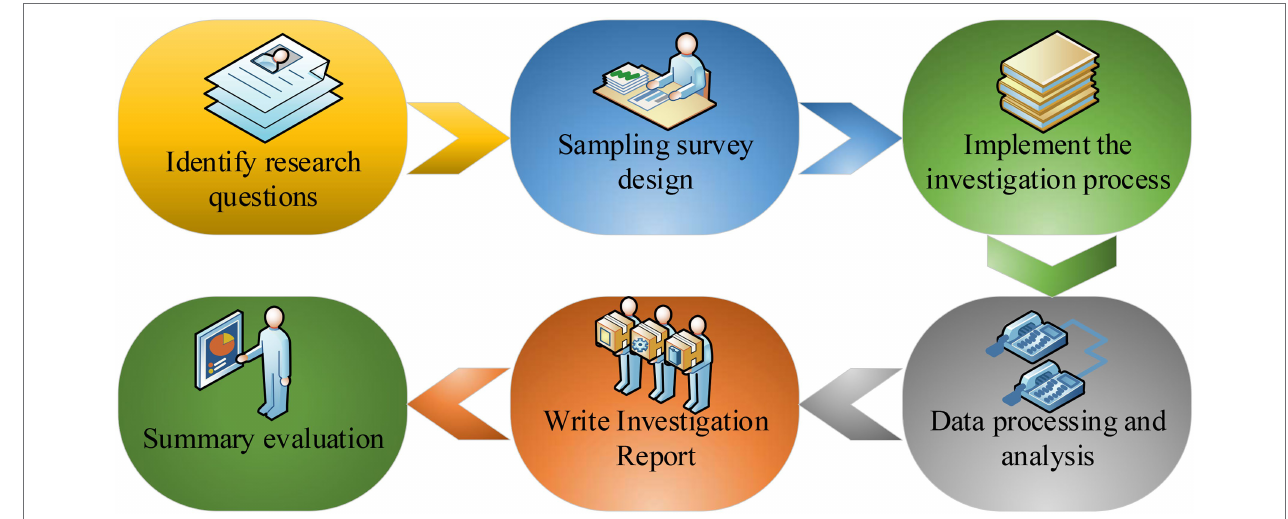
FIGURE 7 | Questionnaire survey steps.